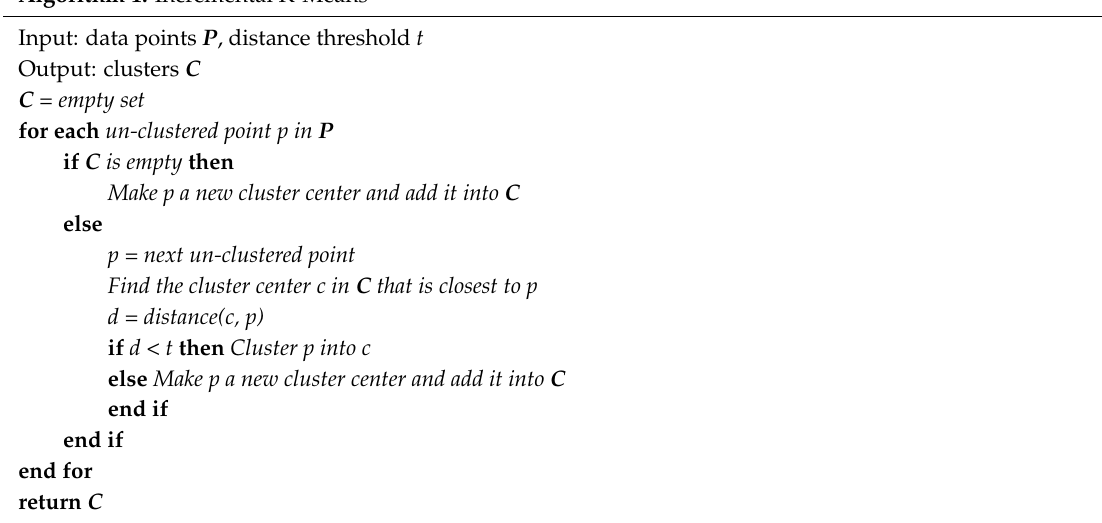
Algorithm 1: Incremental